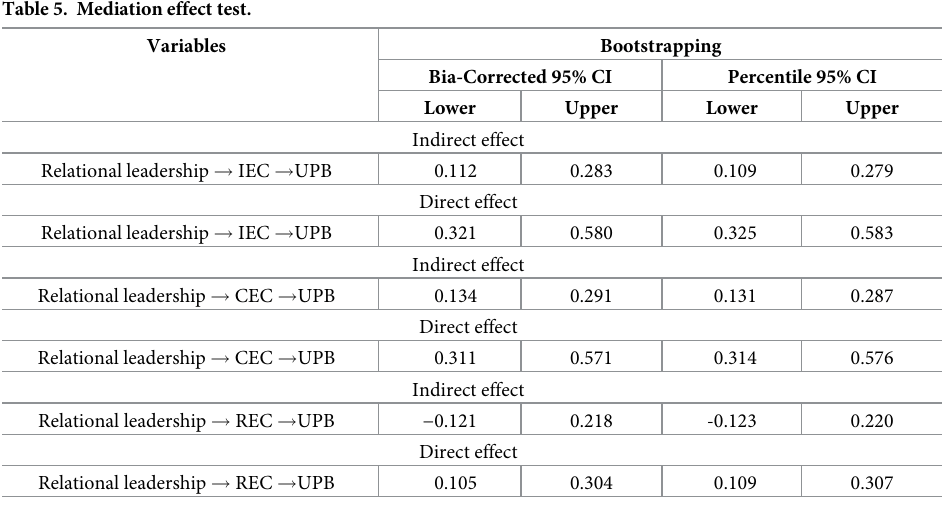
Table 5. Mediation effect